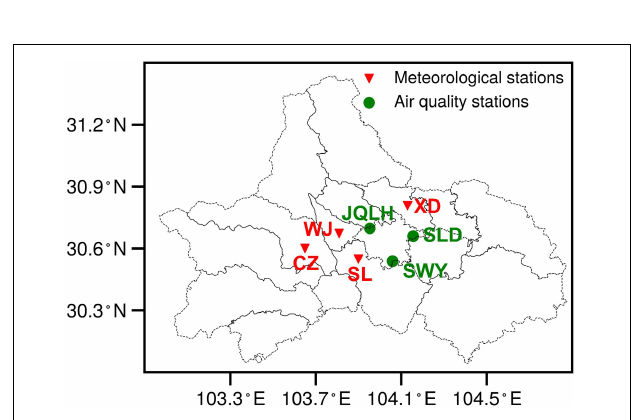
FIGURE 3 | Locations of air quality monitoring stations and meteorological sites in